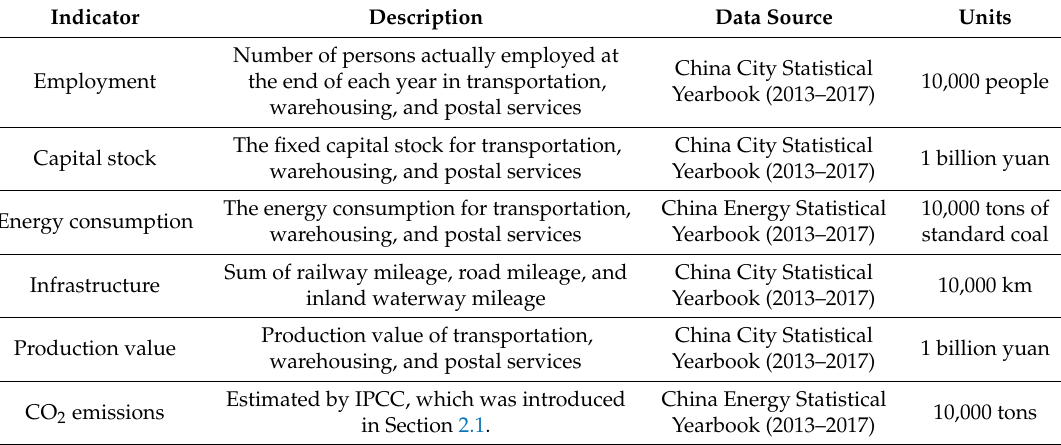
Table 2. A description of the data sources for each